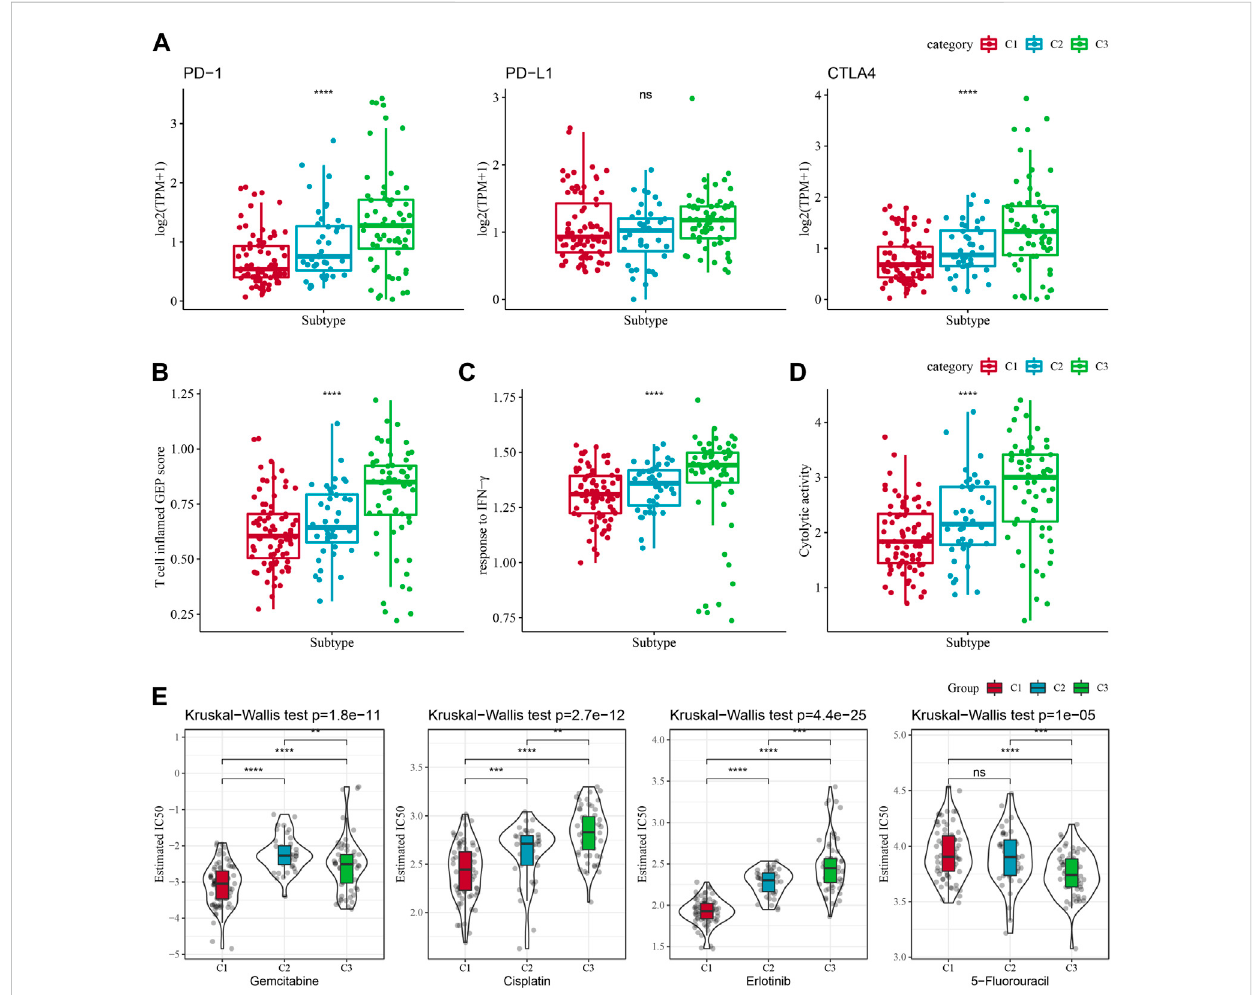
FIGURE 4 Differences in treatment sensitivity among the molecular subtypes. Among different molecular subtypes, (A) Differences in “ T cell in fl amed GEP score ” ; (B) differences in “ response to IFN- γ ” ; (C) Differences in “ response to IFN- γ ". (B) Differences in “ response to IFN- γ ” ; (C) Differences in immune checkpointgeneexpression; (D) Differencesin “ Cytolyticactivity ” ; (E) BoxplotsofIC50ofcisplatin,gemcitabine, 5- fl uorouracil,erlotinibinTCGA-PAAD; * p < 0.05; ** p < 0.01; *** p < 0.001; and **** p <